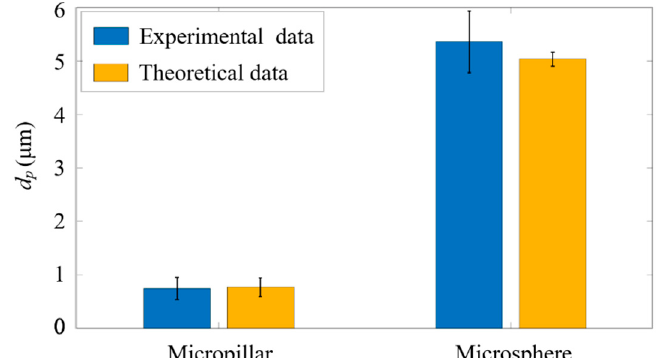
Figure 10. Experimental measurements versus theoretical particle size analysis. The blue histogram represents the size of the particles passing through ADLS. The theoretical data are estimated from SEM images of the particles.